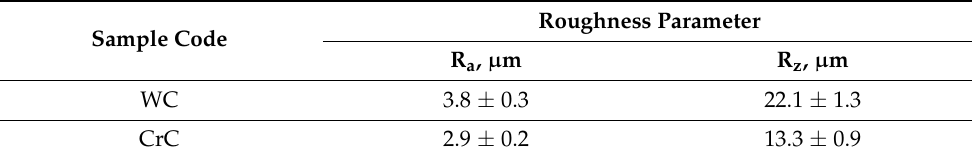
Roughness Parameter